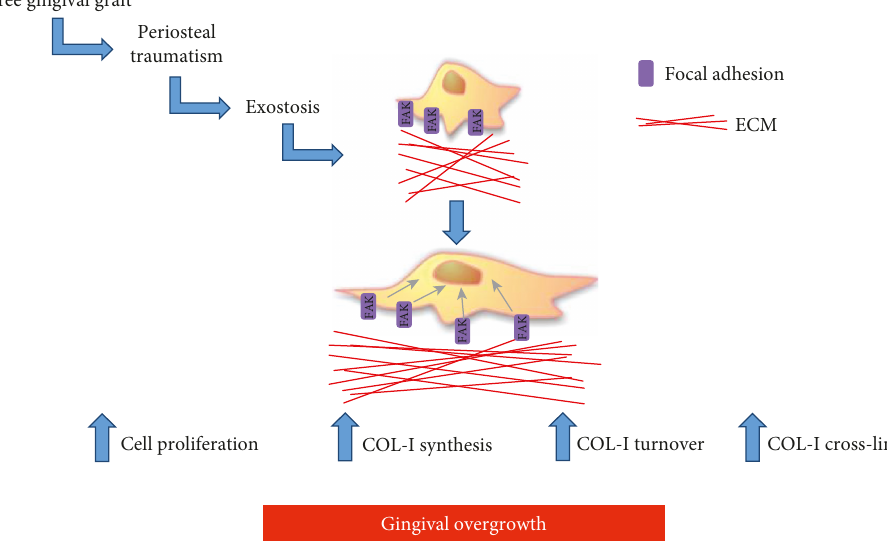
Figure 9: Diagram representing and summarizing the key events that could contribute to the development of gingival overgrowth covering the